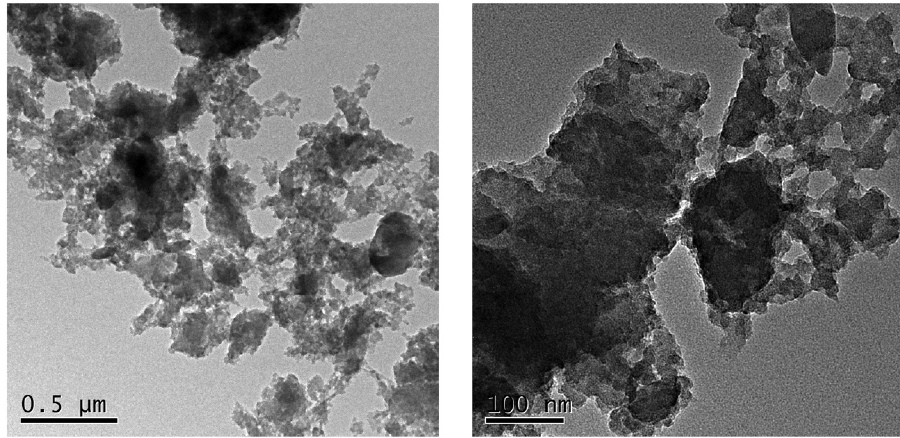
Figure 4: TEM images of Ce - BDC@HSiW@UiO - 66 hybrids.